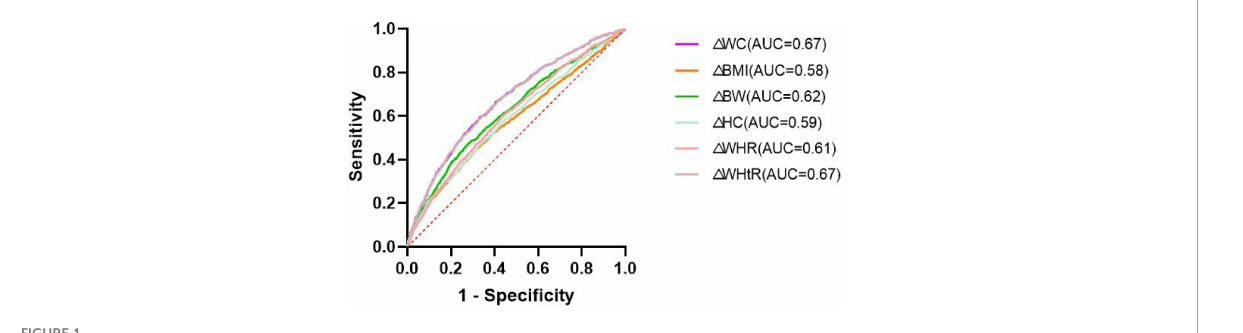
FIGURE 1 The areas under the curves (AUC).